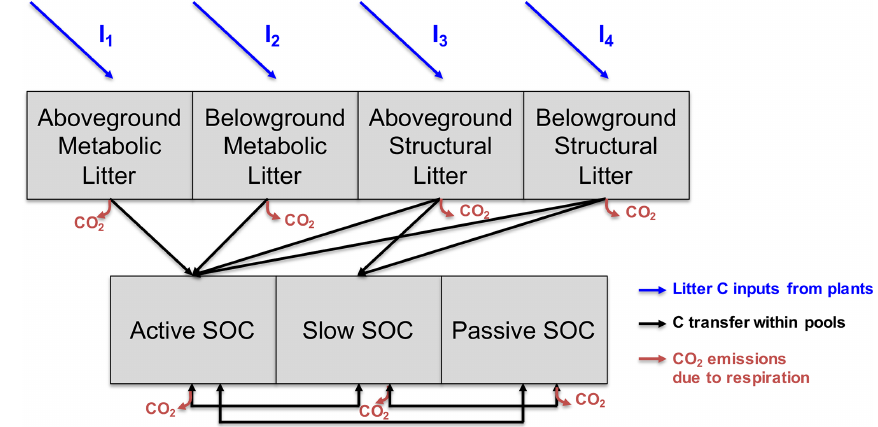
Figure 3. Representation of litter and soil organic carbon (SOC) pools in Century. The model takes as input litter carbon from plants (aboveground metabolic ( I 1 ), belowground metabolic ( I 2 ), aboveground structural ( I 3 ) and belowground structural ( I 4 ) ). A certain fraction of carbon can be transferred from one pool to another, and each time a transfer occurs, part of this carbon is respired and leaves the system to the atmosphere as CO 2 . The SOC active pool receives carbon from each litter pool, while only the structural material is transferred to the SOC slow pool. Litter material never goes directly to the SOC passive pool while the three SOC pools exchange C within each